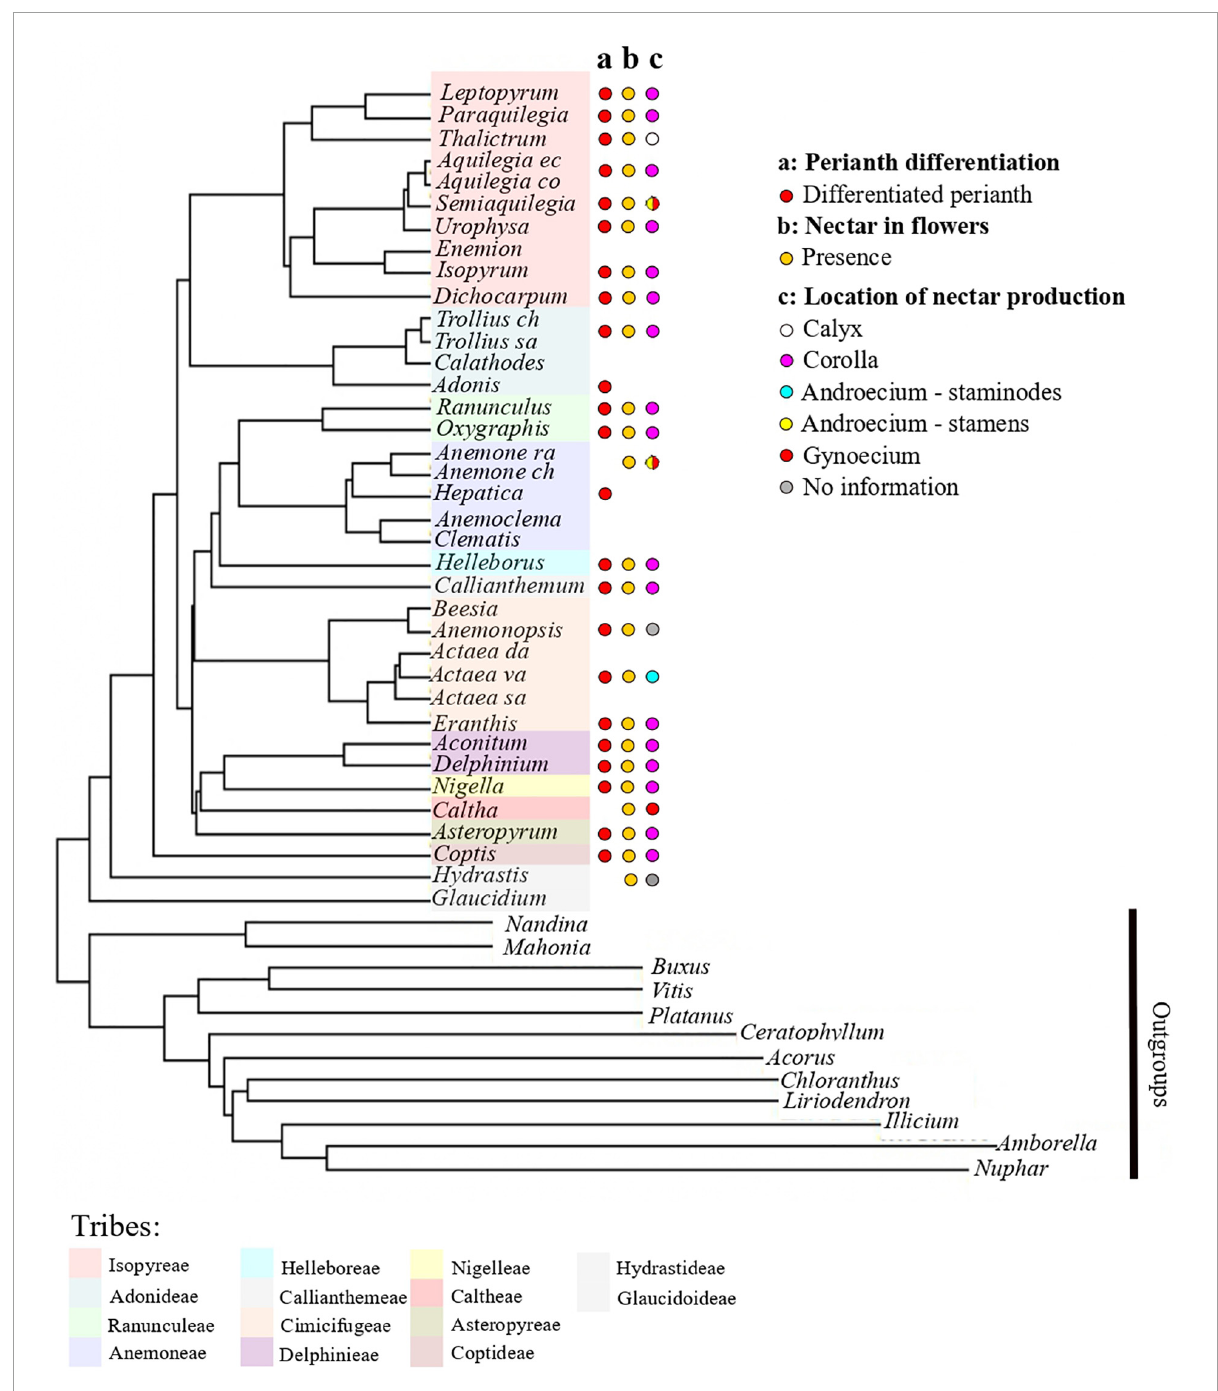
FIGURE5 Phylogeny of the Ranunculaceae (adapted from Zhai et al., 2019) with the mapping of functional characters. (a) Perianth differentiation, (b) nectar in flowers, (c) location of nectar production. Color code for tribes as in Figure 3 .